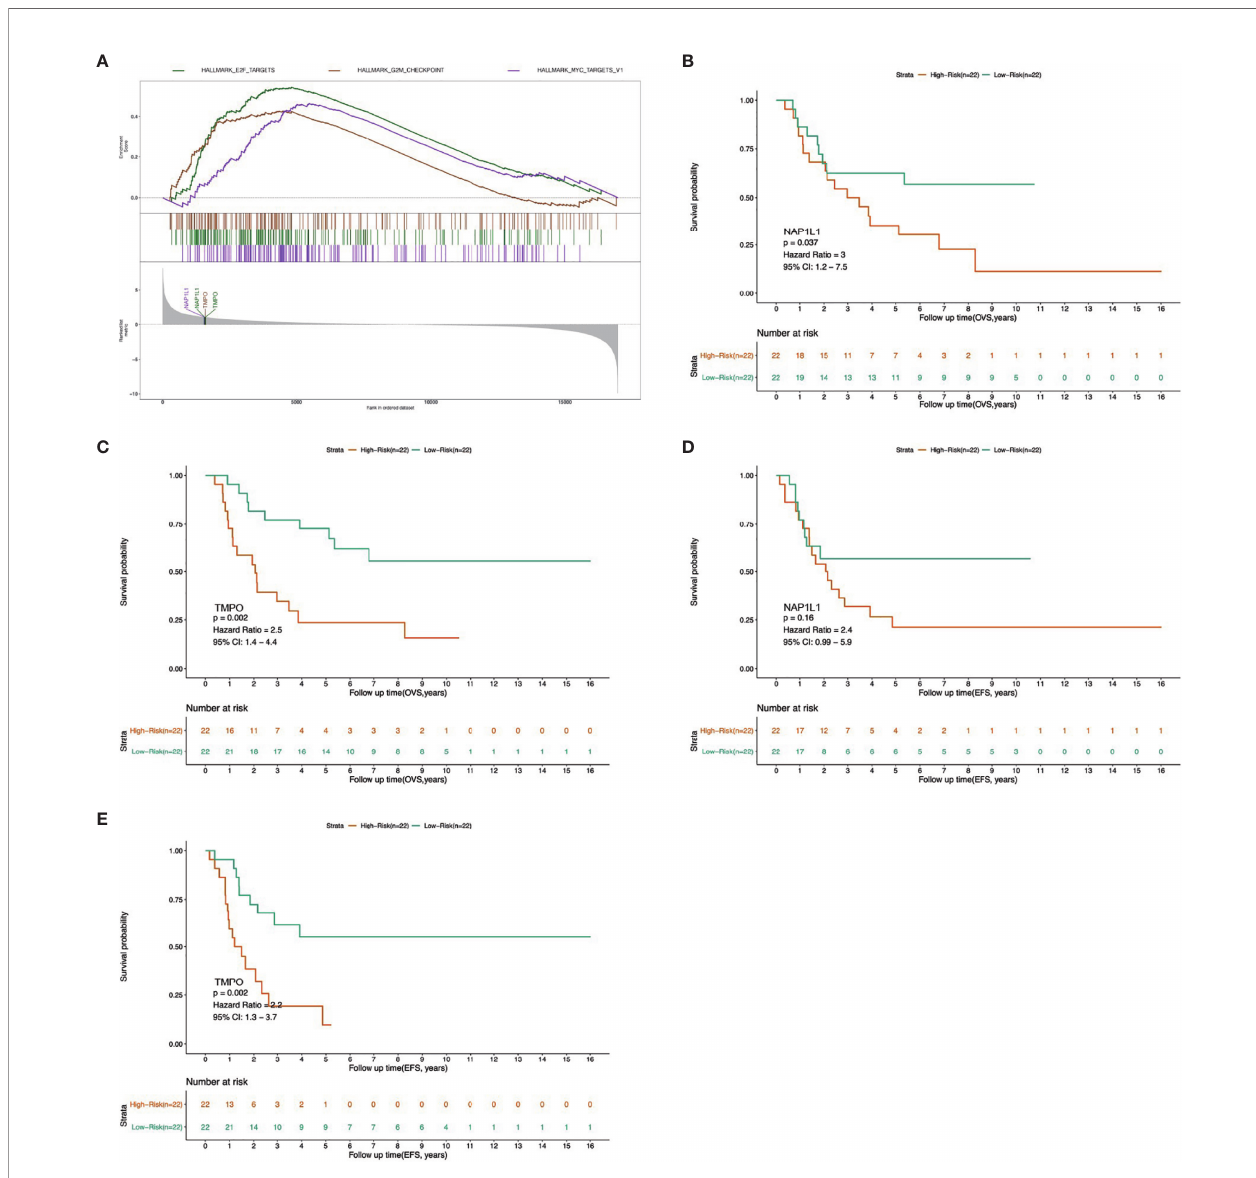
FIGURE 7 | Determination of the molecular mechanism of FOXP4-AS1 by GSEA analysis. (A) Across GSVA and GSEA datasets, two crucial genes associated with commonly up-regulated cascades were identi fi ed in the ceRNA network. (B – E) Survival analysis and univariate Cox regression analysis revealed association of the two crucial genes with overall survival (OVS) and event-free survival (EFS) of ES